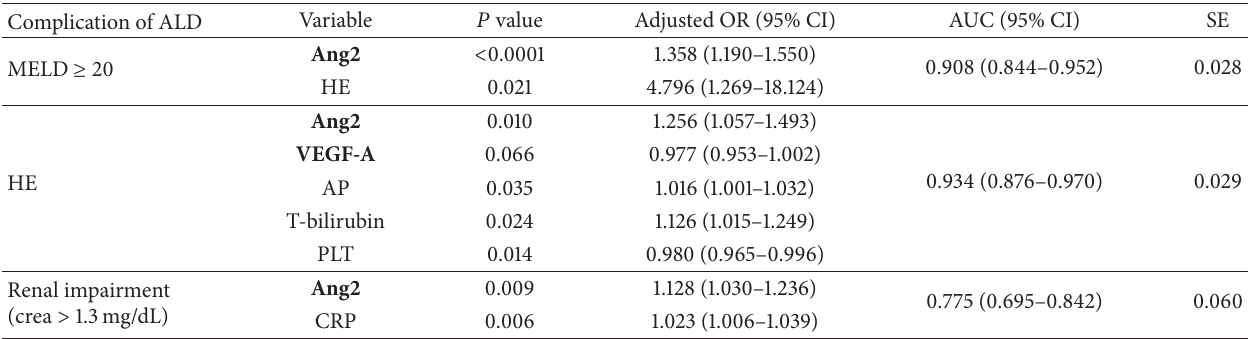
Table 7: Independent predictors of advanced liver dysfunction (MELD ≥ 20) and ALD complications (multivariable analysis) ∗ . Complication of